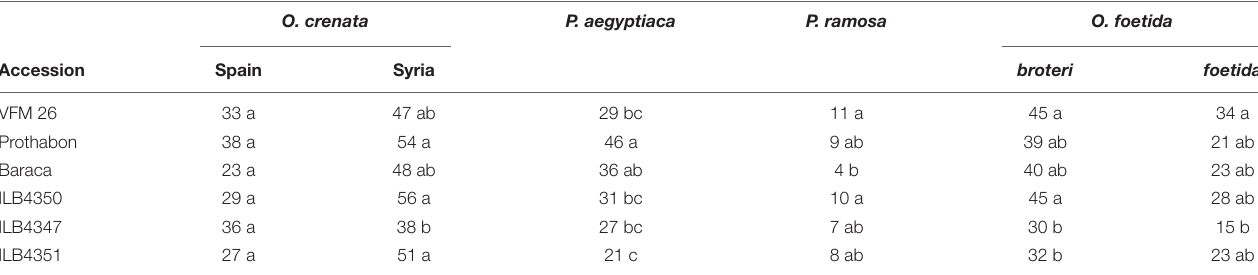
TABLE 3 | Percentage of germinated broomrape seeds contacting roots of faba bean accessions.